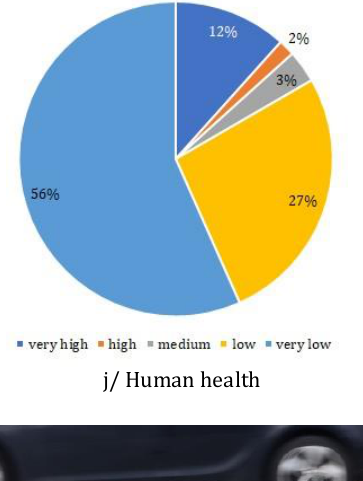
Fig. 6. The negative impacts of invasive alien plant species on the environmental domain, economy, ecosystem services and human health calculated according to Harmonia +PL procedure